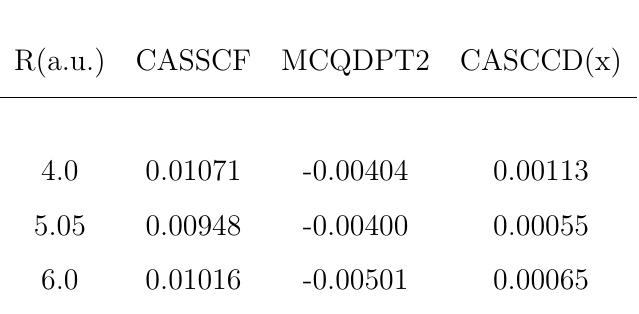
with different symmetries calculated 2